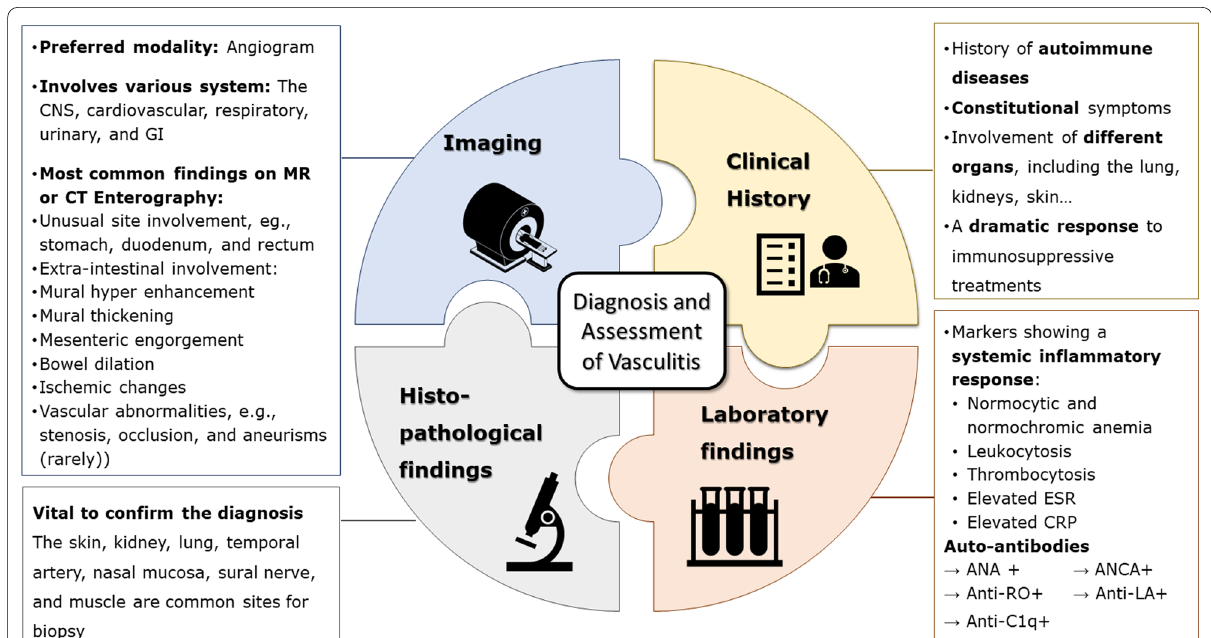
Fig. 24 The diagnosis of intestinal vasculitis is based on a combination of the clinical manifestation and history, imaging, laboratory, and histopathology